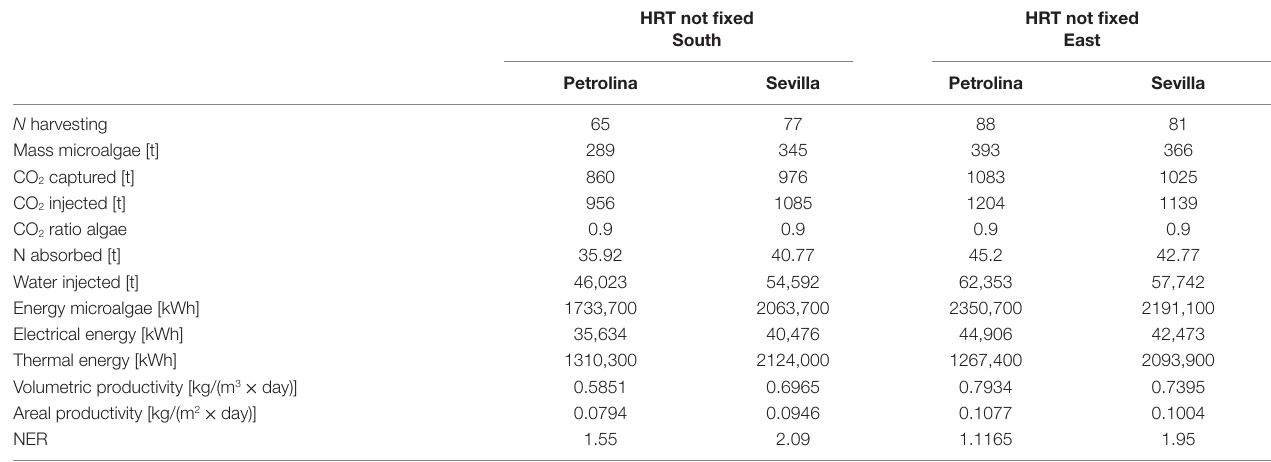
TaBle 8 | results from flat panel simulations using the first operating strategy, meaning that input and output microalgae concentrations are